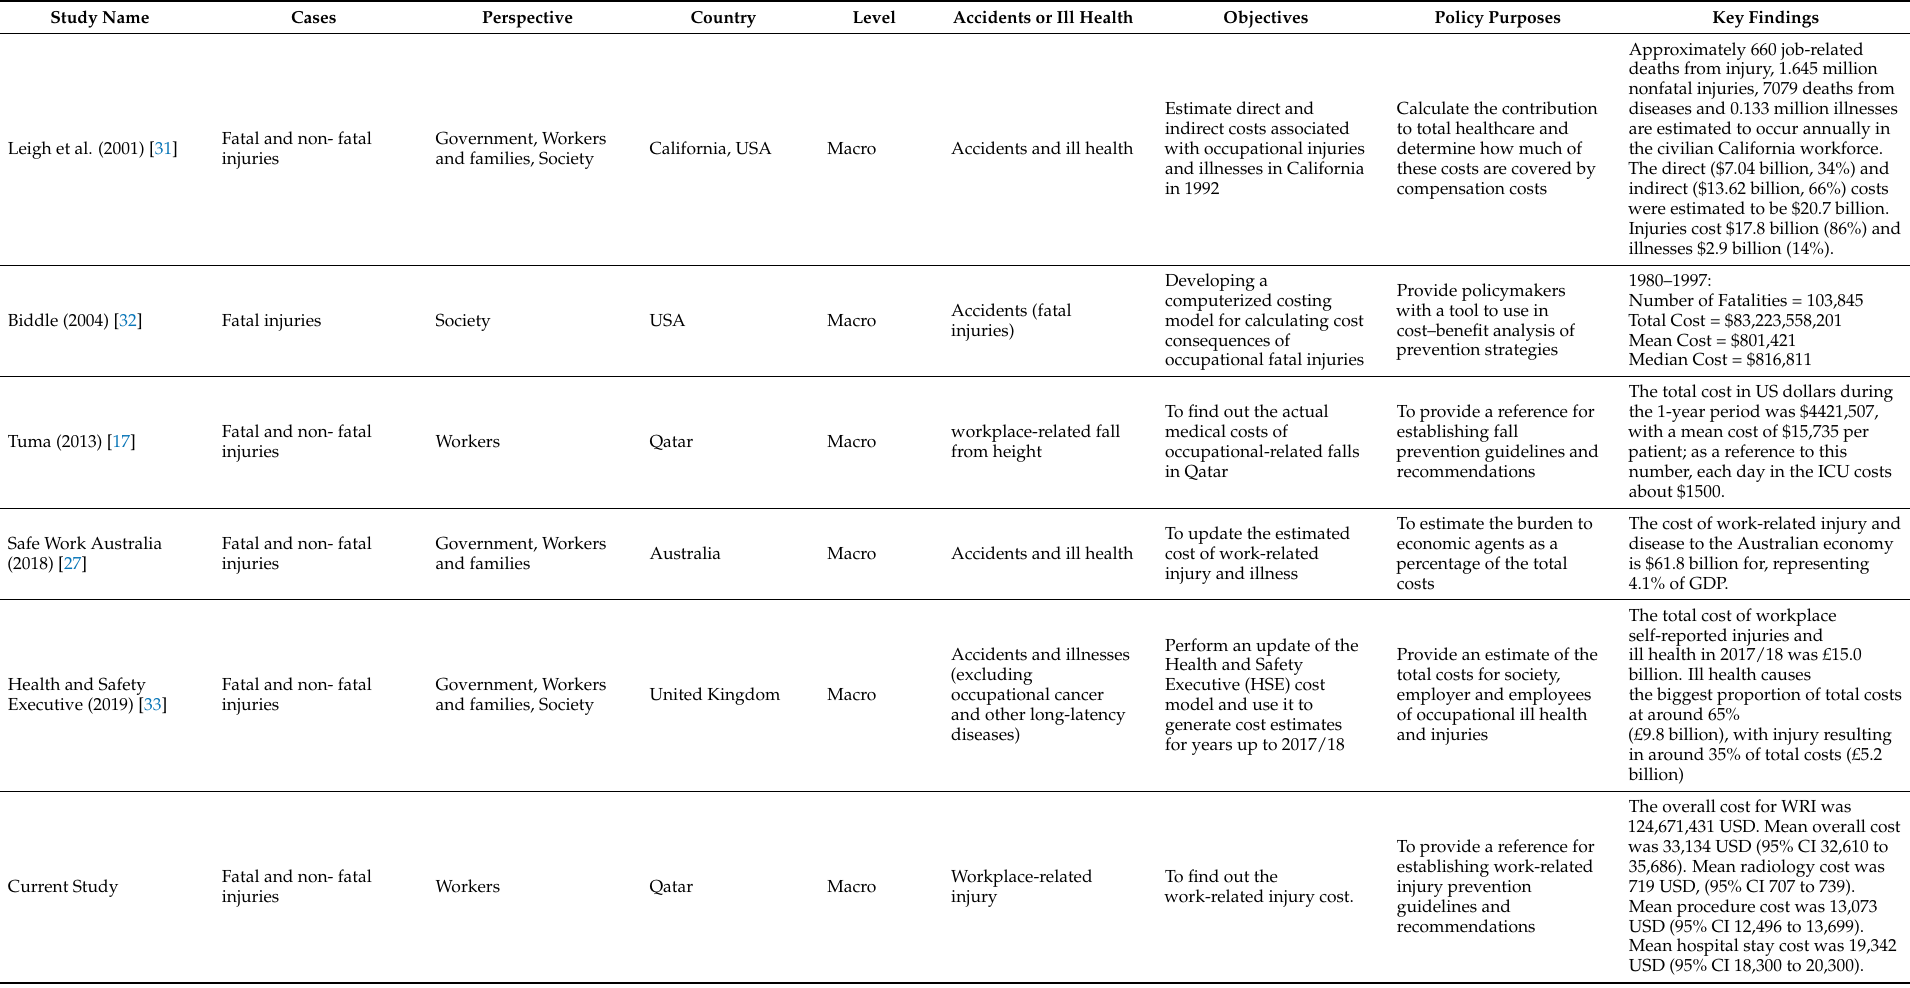
Table 5. Description of studies reporting costs associated with work-related injuries